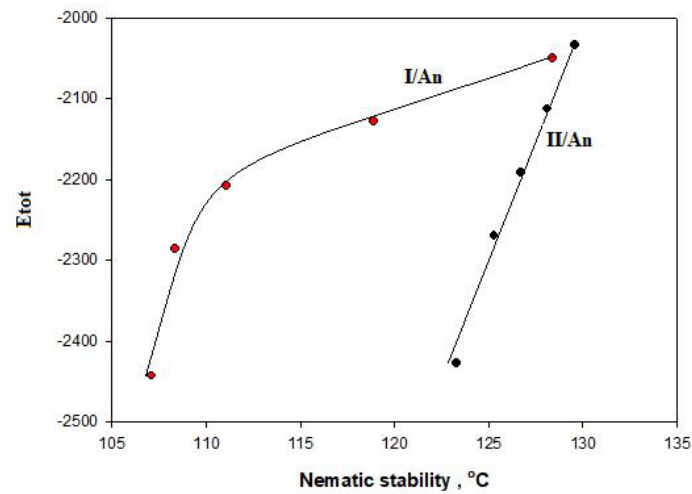
Figure 7. Relationship between the sum of the electronic & thermal energies of H-bonded complexes. I/An and II/An with their nematic mesophase stabilities in the chair-shaped conformers.